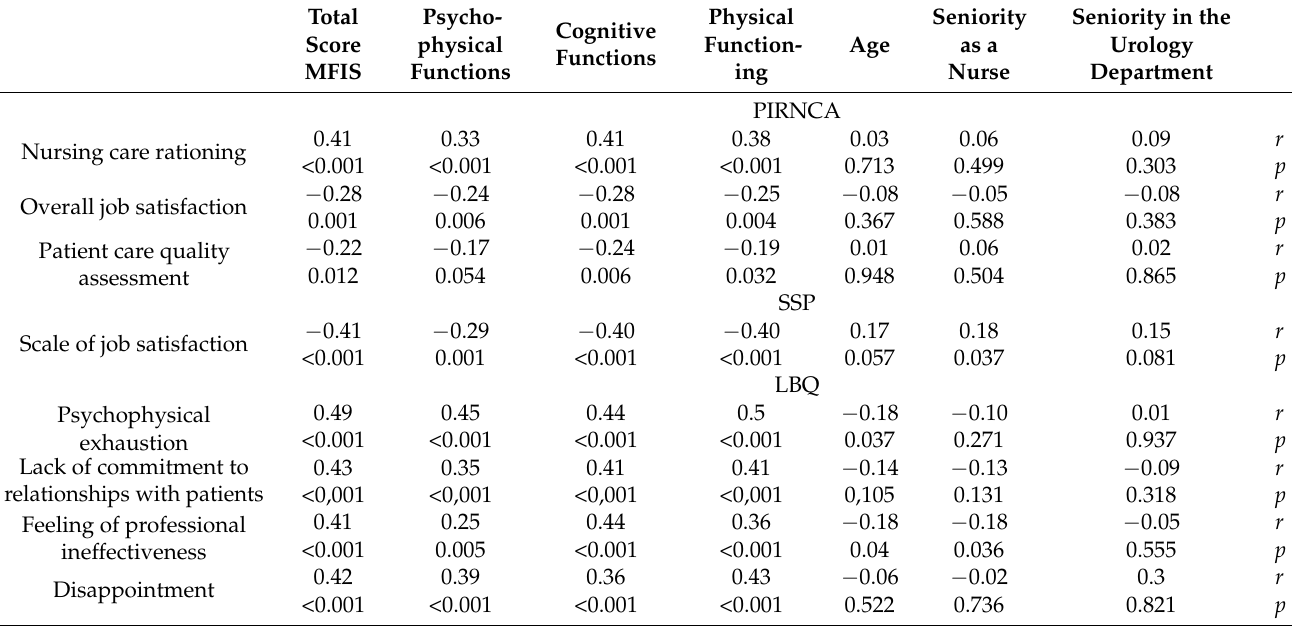
Table 2. The relationship between fatigue, age, seniority and rationing care, job satisfaction and